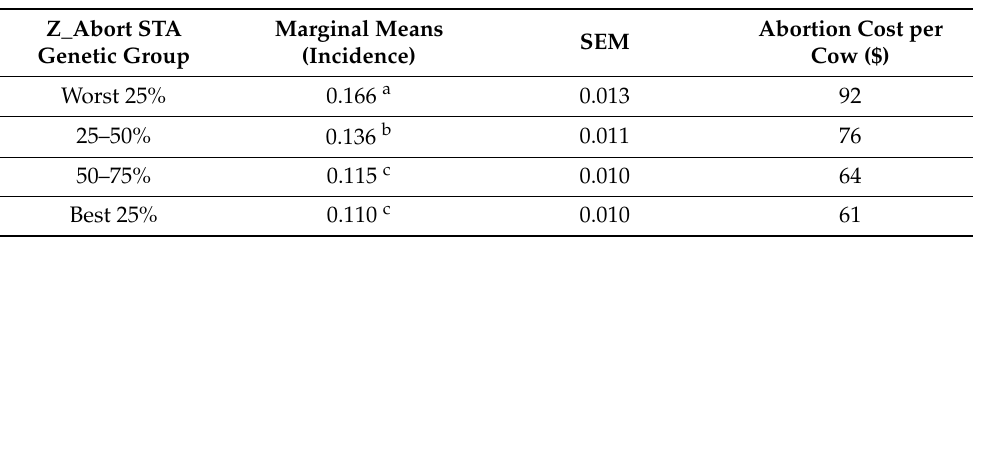
Table 5. Least squares means for genomic cow abortion (Z_Abort STA) groups (n = 4) abortion incidence ( p < 0.0001), SEM of the genetic groups, and estimated abortion cost per cow. a–c Different letters within the same column represent p <